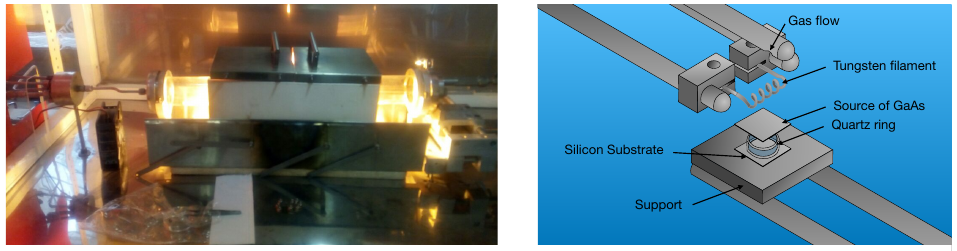
Figure 1. Schemes and photography of the deposition and nitriding systems.